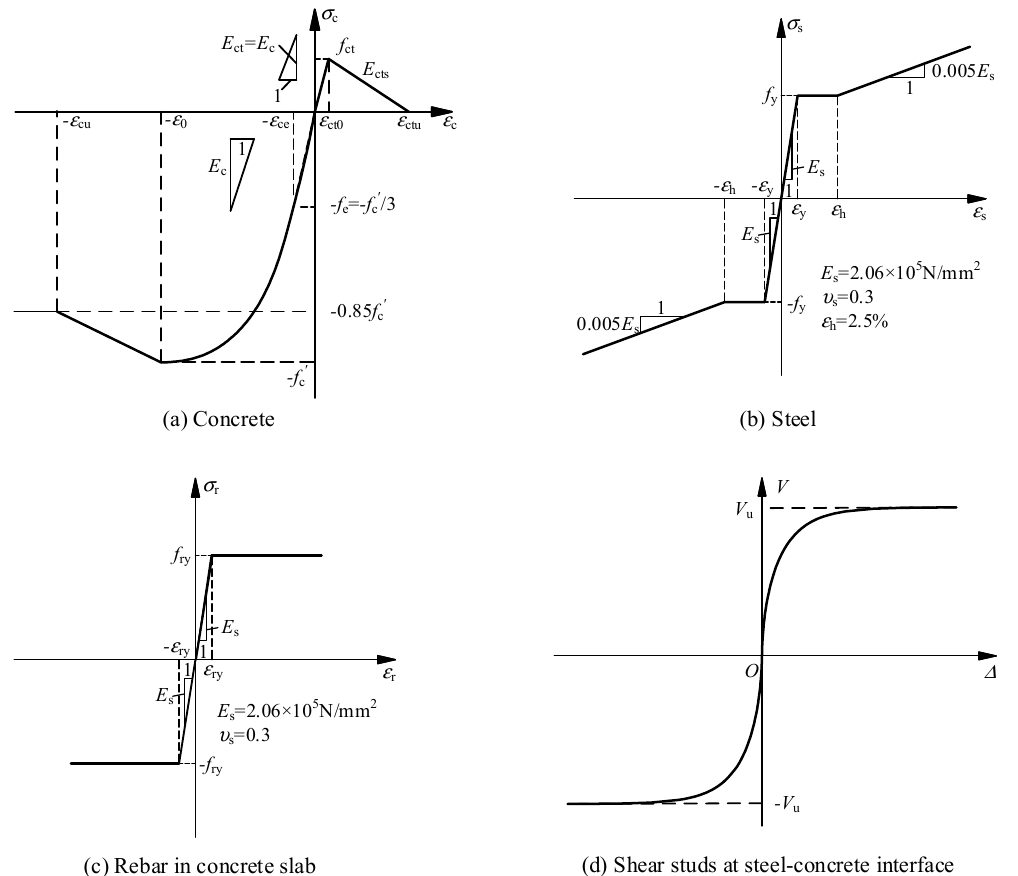
Figure 15. The uniaxial constitutive relationship of the FE model. According to the research of Guo [31], CEB-FIP 1990 [32], and Bazant and Oh [33], the uniaxial tensile stress–strain relationship of concrete is shown in Figure 15a. Equations (3)–(5) give the calculation formula of the curve in Figure